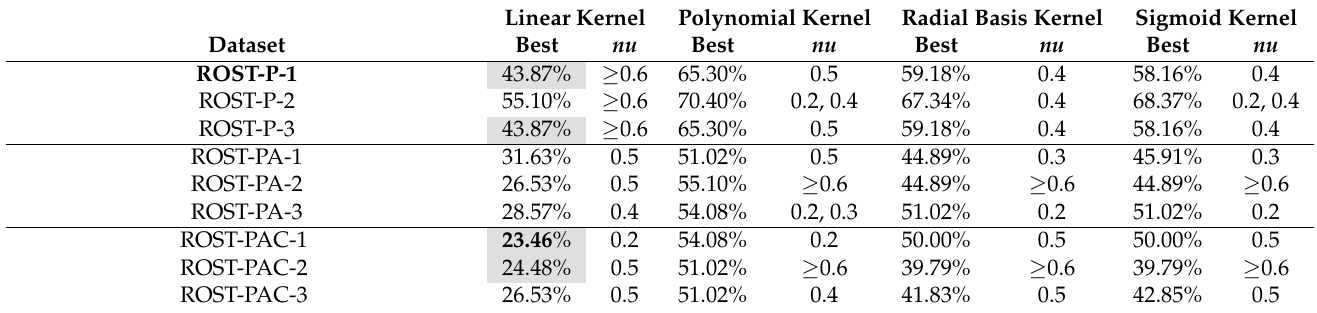
Table 14. SVM results on the considered datasets. The number of incorrectly classified data is given as a percentage (the best results obtained by SVM on any ROST-*-* dataset representation are in bold). Best stands for the best test error rate (out of 30 runs with nu ranging from 0.001 to 1), and nu stands for the parameter specific to the selected type of SVM (i.e., nu-SVC). Results are given for each type of kernel that was used by the SVM. The best result obtained by SVM compared to all methods for a given ROST-X-n dataset representation is in a gray